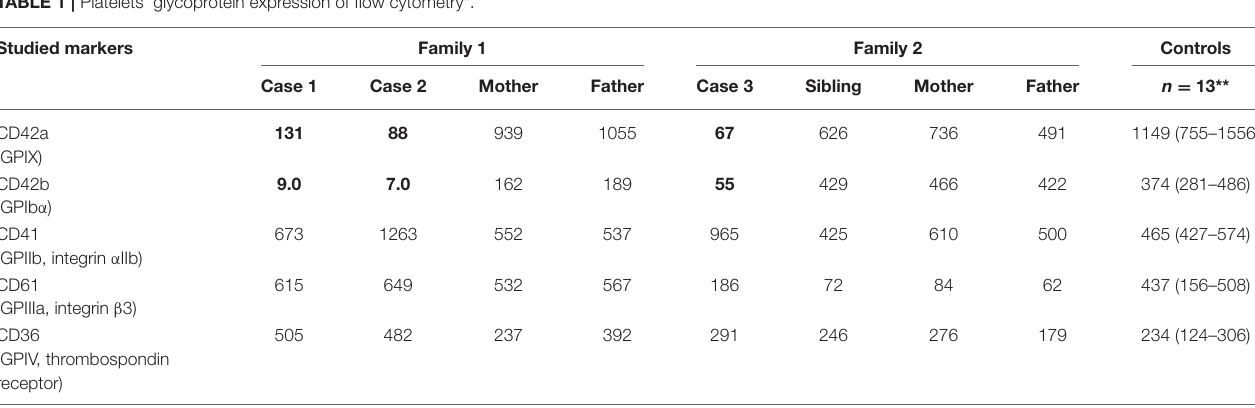
TABLE 1 | Platelets’ glycoprotein expression of flow